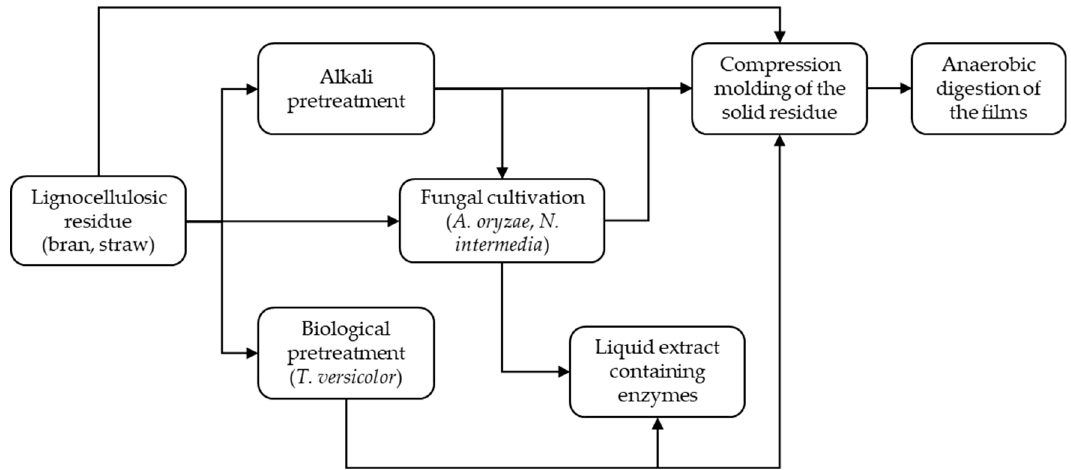
Figure 1. Flowchart showing the stages studied for the production of wheat bio-based materials.